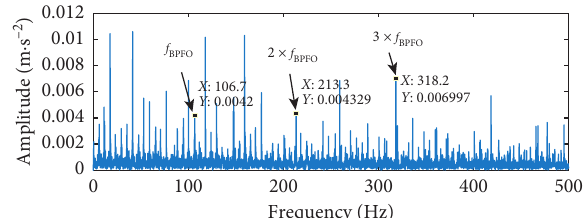
Figure 15: Experimental frequency domain signal for a localized fault which is 0.014 inches and the speed is 1772rpm.